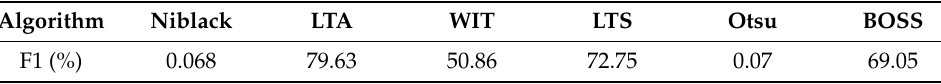
Table 8. Summary of algorithms’ best F1